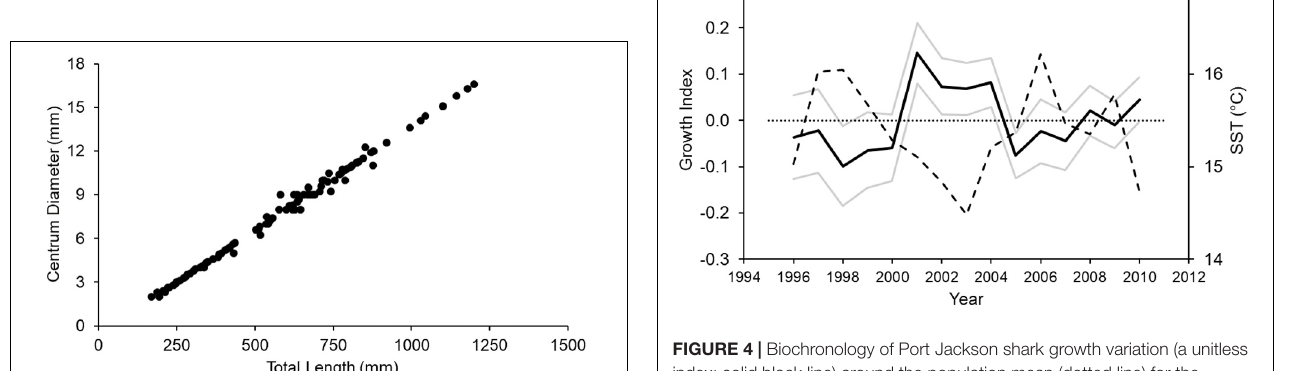
FIGURE 4 | Biochronology of Port Jackson shark growth variation (a unitless index; solid black line) around the population mean (dotted line) for the duration of the period studied (model intercept). Standard errors are shown as solid gray lines. The dashed line is the mean sea surface temperature (in ◦ C) over the breeding season (austral winter to spring) of the